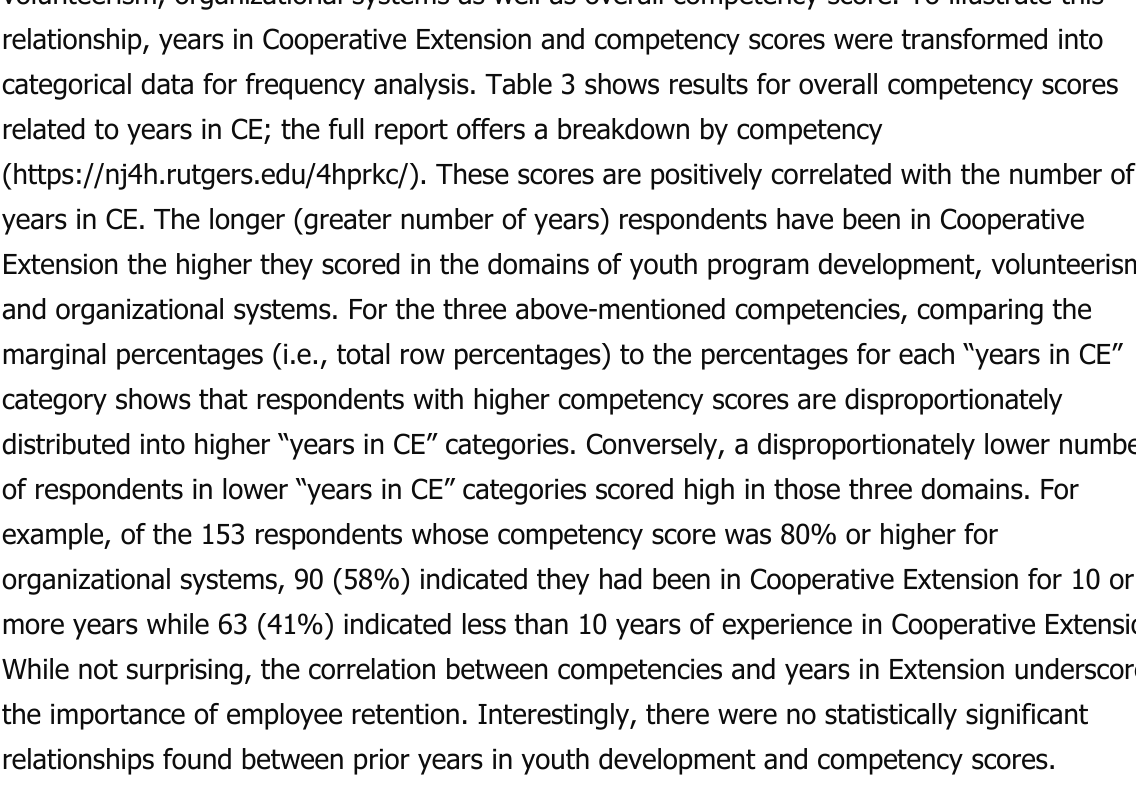
Table 2. Self-Assessment Competency Score by Domain Domains (n = 188) Youth Development Youth Program Development Volunteerism Access, Equity, and